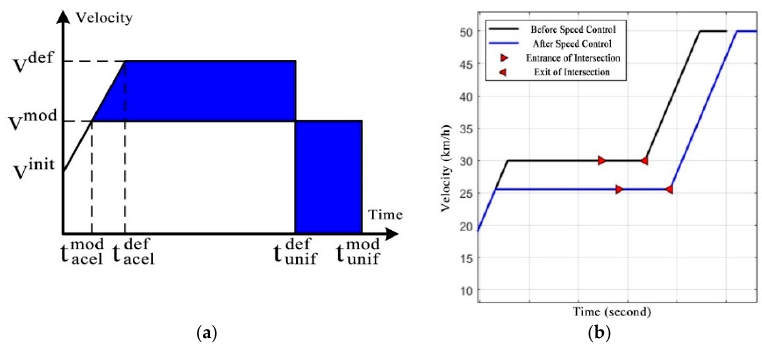
Figure 12. Speed control solution for vehicle B. ( a ) Velocity difference before and after speed control; ( b ) speed control strategy.